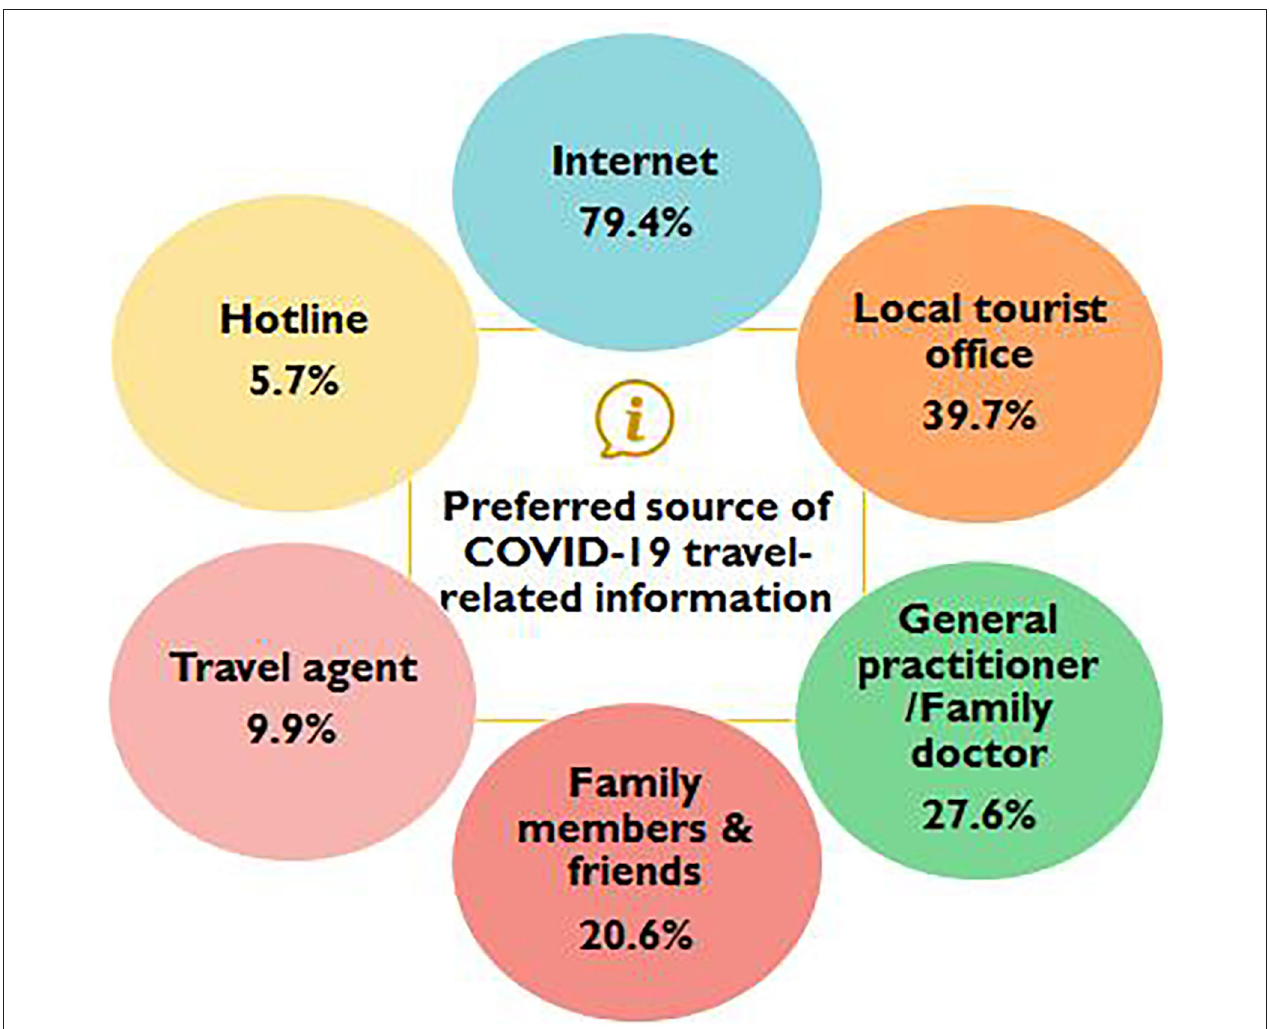
FIGURE 2 | Preferred source of COVID-19 travel-related information ( N =